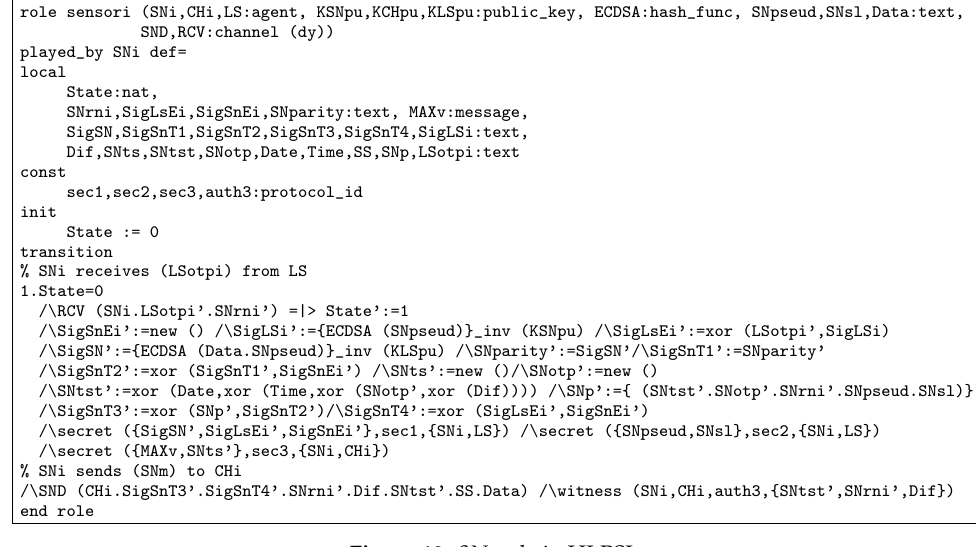
Figure 10. SN i role in HLPSL.